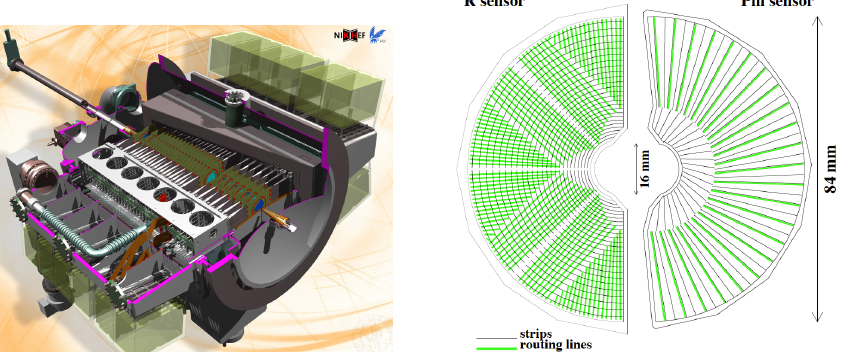
Figure 1. A visualization of the Vertex Locator showing the detector stations placed along the beam line (on the left ). The RF foil and cooling mechanism are also visible. The scheme of R and Φ type of sensor (on the right )